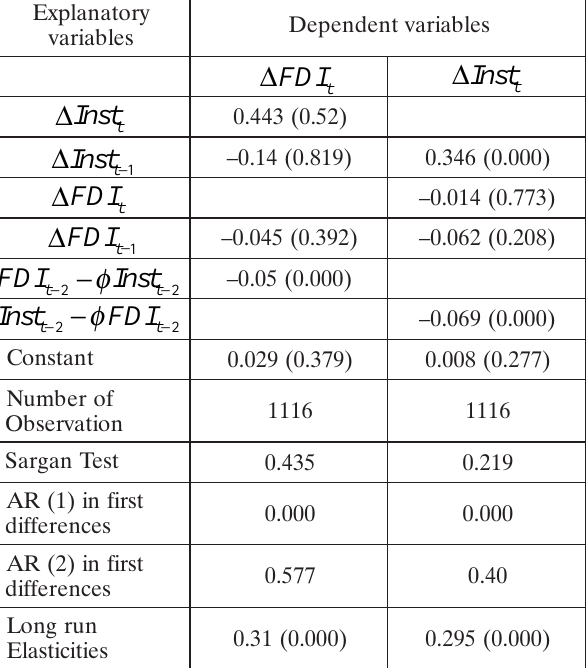
Table 6. Panel Error Correction